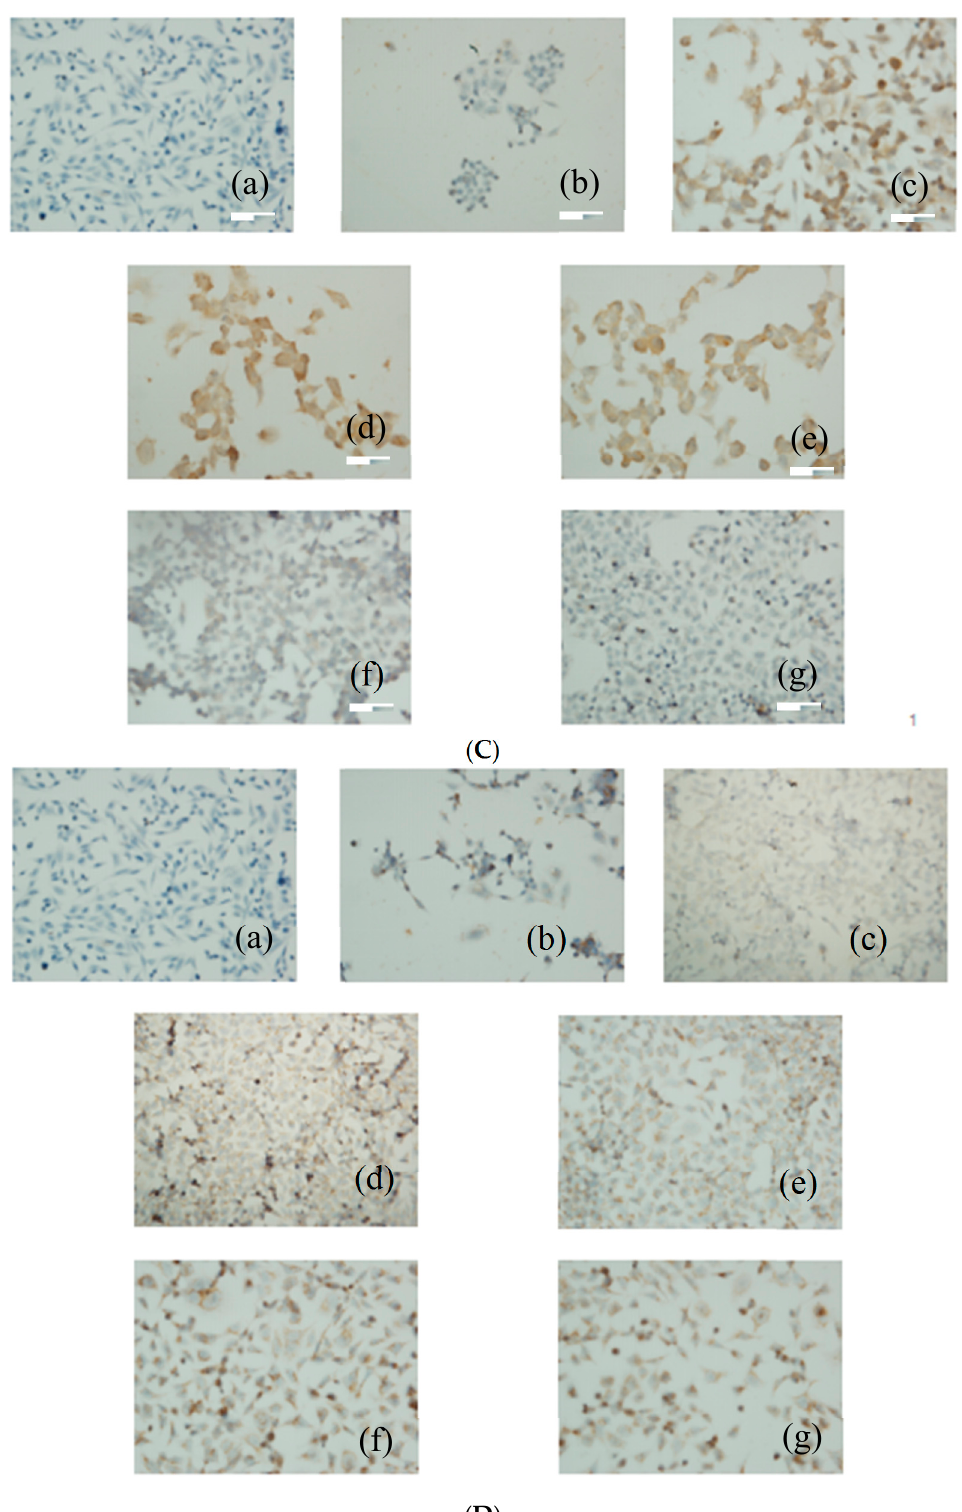
Figure 6 . Cont . Figure 6. Cont